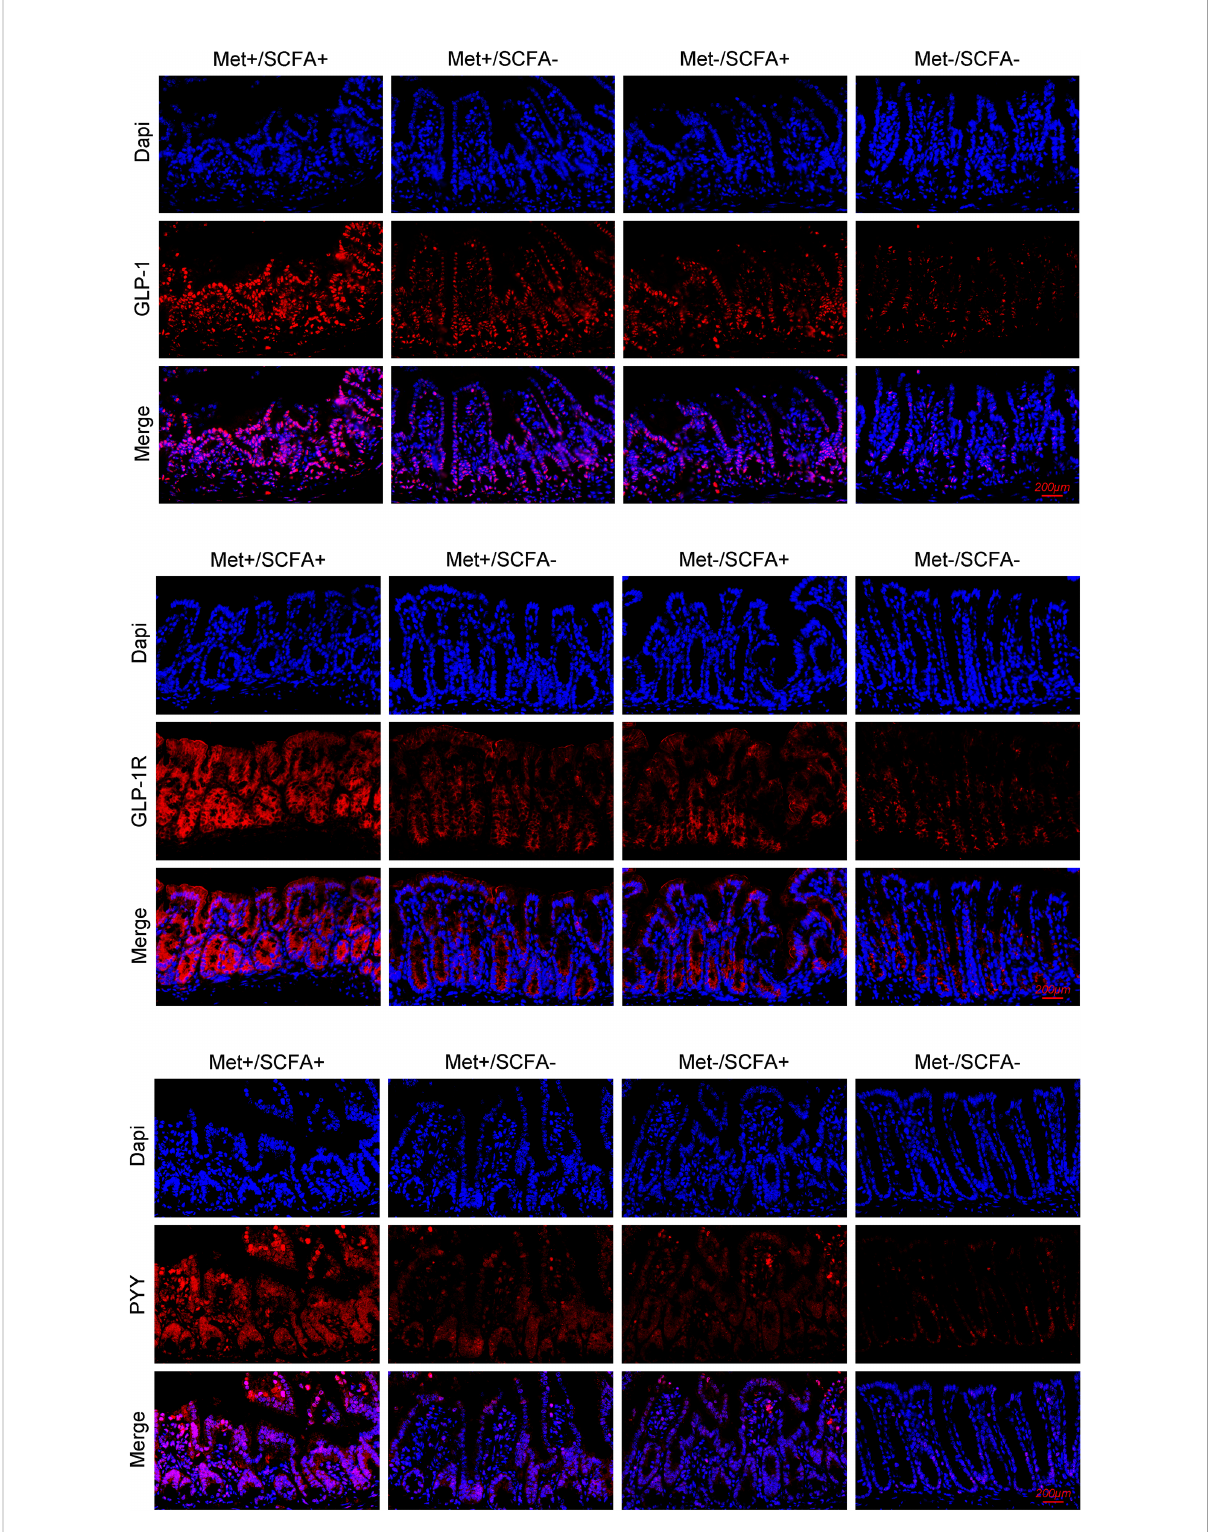
FIGURE 6 The expression levels of GLP-1, GLP-1R and PYY. Met, metformin; Clin, clindamycin; SCFA, short-chain fatty